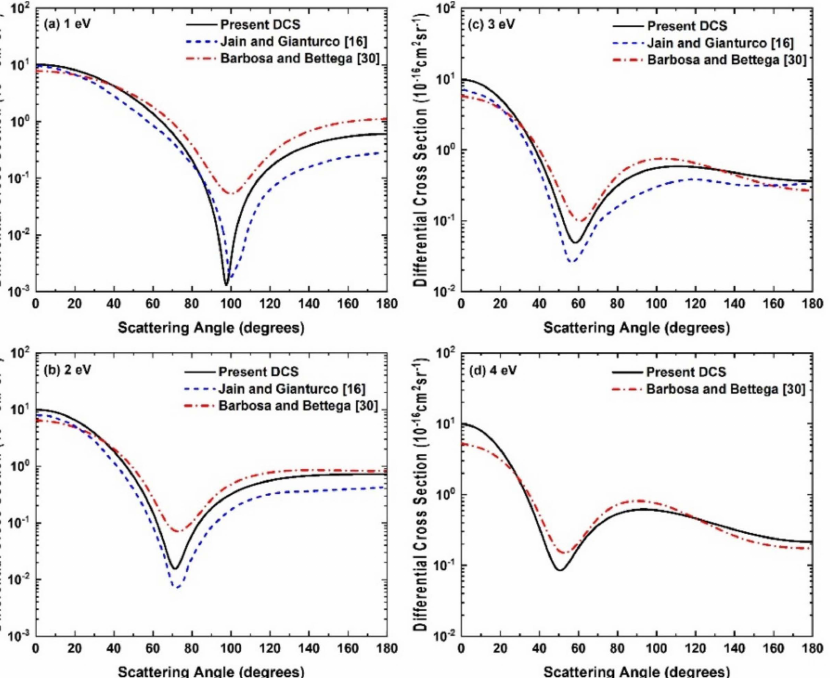
Figure 6. Differential cross sections for positron-SiH 4 elastic scattering at incident positron energies ( a ) 1 eV, ( b ) 2 eV, ( c ) 3 eV and ( d ) 4 eV. Solid line, present DCS; dashed line, Jain and Gianturco [16]; dashed dot line, Barbosa and Bettega